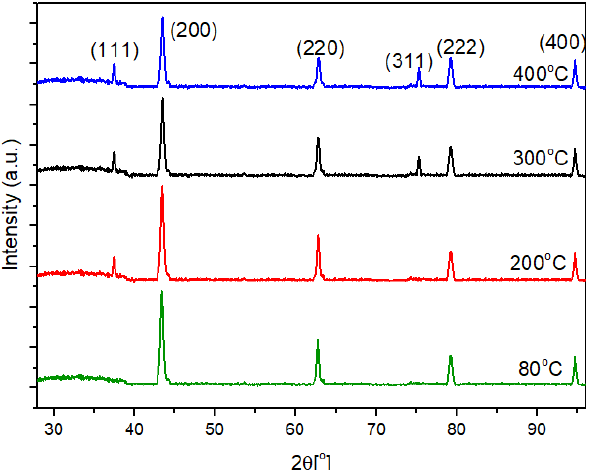
Figure 1: X-ray diffraction pattern of titanium oxide of deposited at 80 ∘ C and annealed at temperatures of 200, 300 and 400 ∘ C